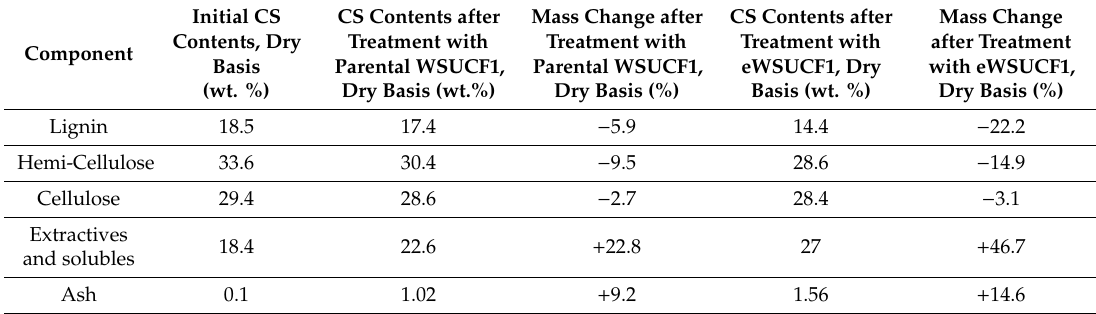
Table 1. Chemical analysis of the corn stover